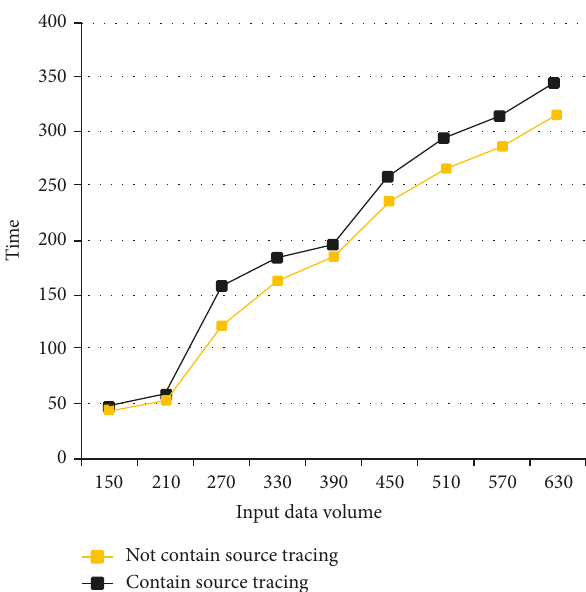
Figure 7: Execution time of the reduced phase of big data